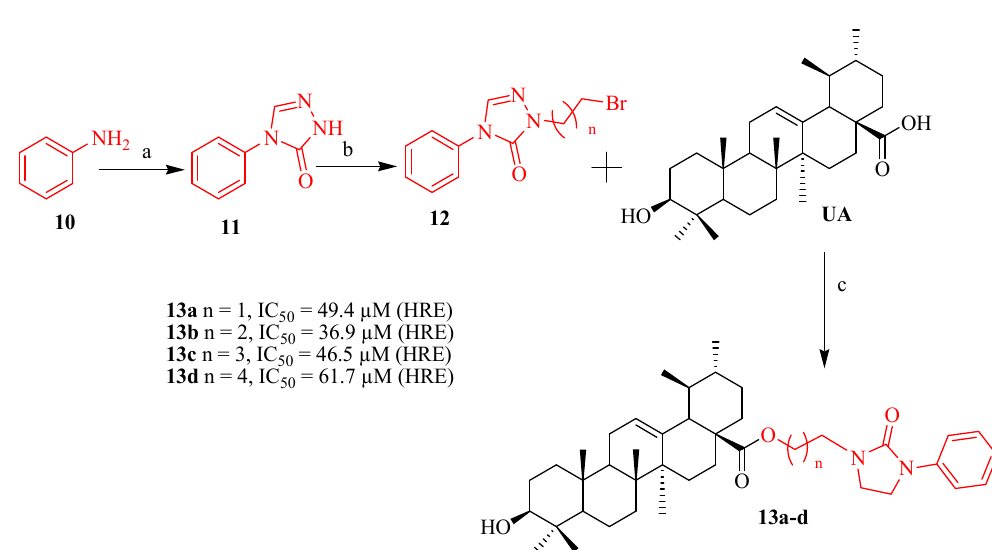
Table 3. IC 50 values of UA derivatives modified on the carboxylic moiety (C-28).